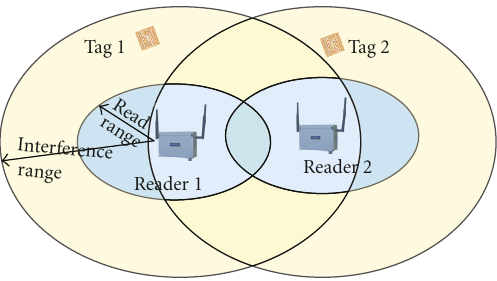
Figure 1: Reader-Tag Collision Problem: responses of a tag to a reader when queried are drowned out by the interfering signal from another concurrently operating reader in the vicinity. In this example, Tag 2 is within the read range of Reader 2. Reader 2 is also in the interfering range of Reader 1. After Reader 2 queries Tag 2 for its ID, the response of Tag 2 at Reader 2 is interfered with by the signal from Reader 1 which was querying Tag 1 at the same time.